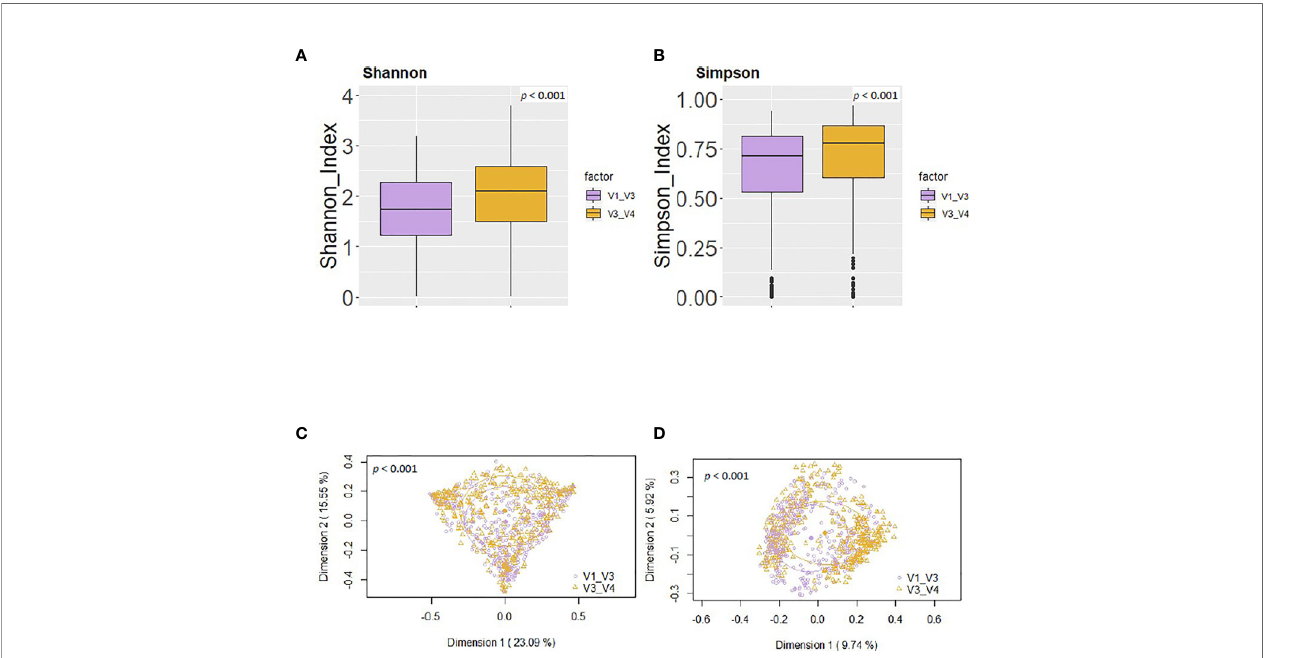
FIGURE 4 | Comparison between the values of alpha and beta diversity obtained after the analysis at the genus level of the same set of milk samples, either with the V3-V4 (this work) or the V1-V3 (Lackey et al., 2019) approach. (A) Shannon diversity index; (B) Simpson diversity index; (C) PCoA plots based on the Bray-Curtis dissimilarity index; (D) PCoA plots based on the Jaccard ’ s coef fi cient with the SILVA 132 database.